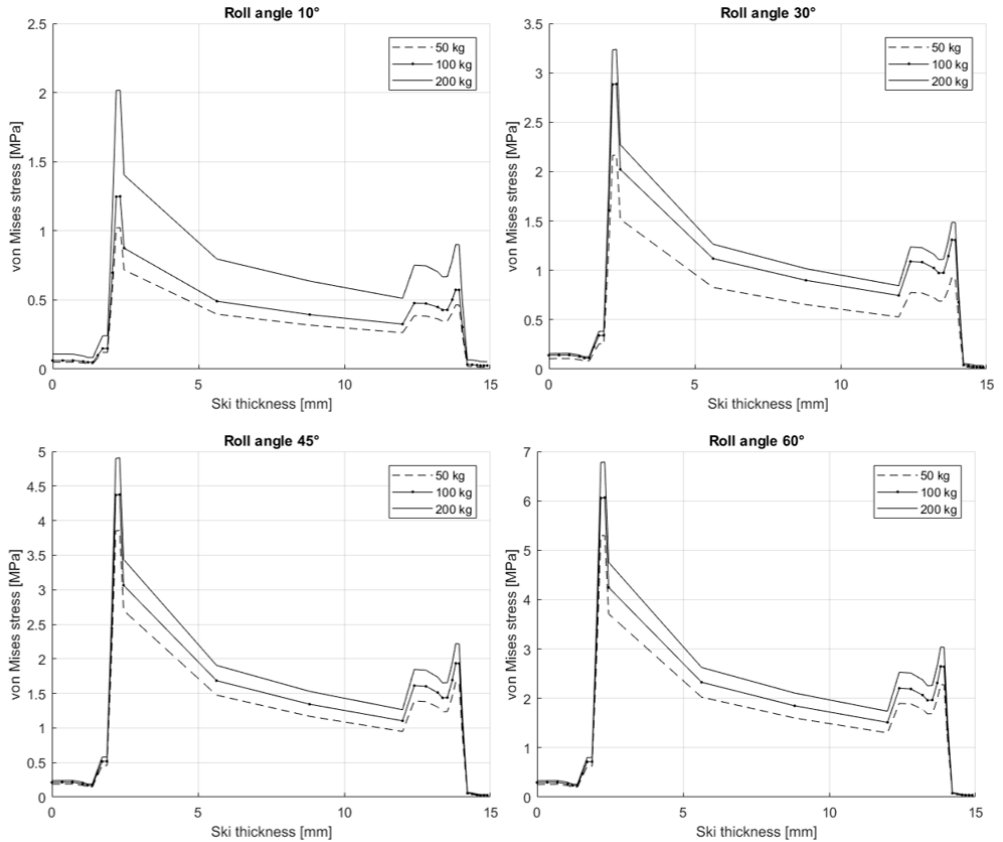
Figure 21. Von Mises stress in the cross-section of the ski for different roll angles and loads.